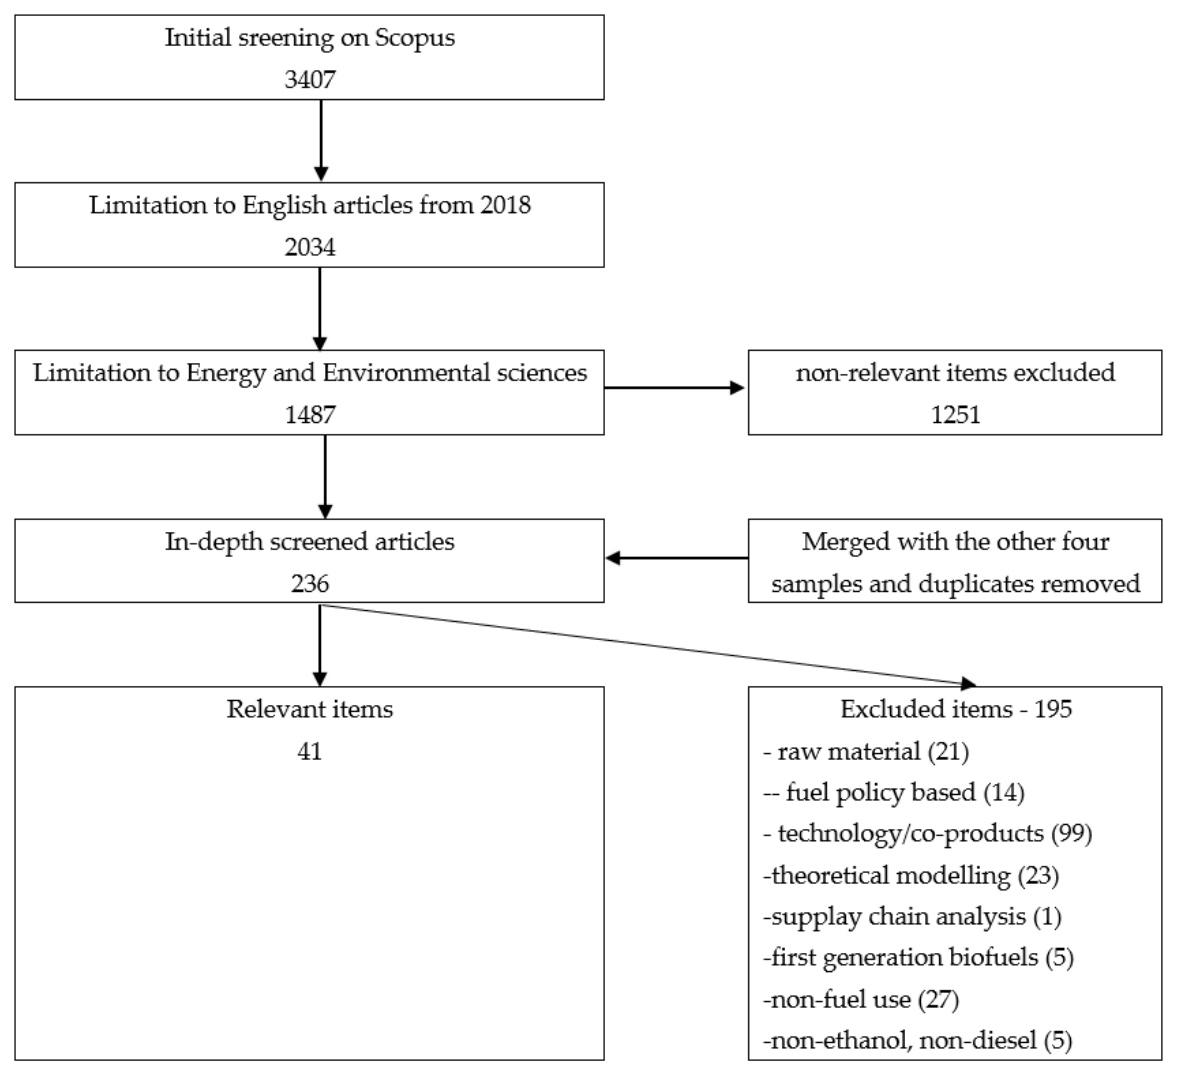
Figure 5. Steps of the selection process.